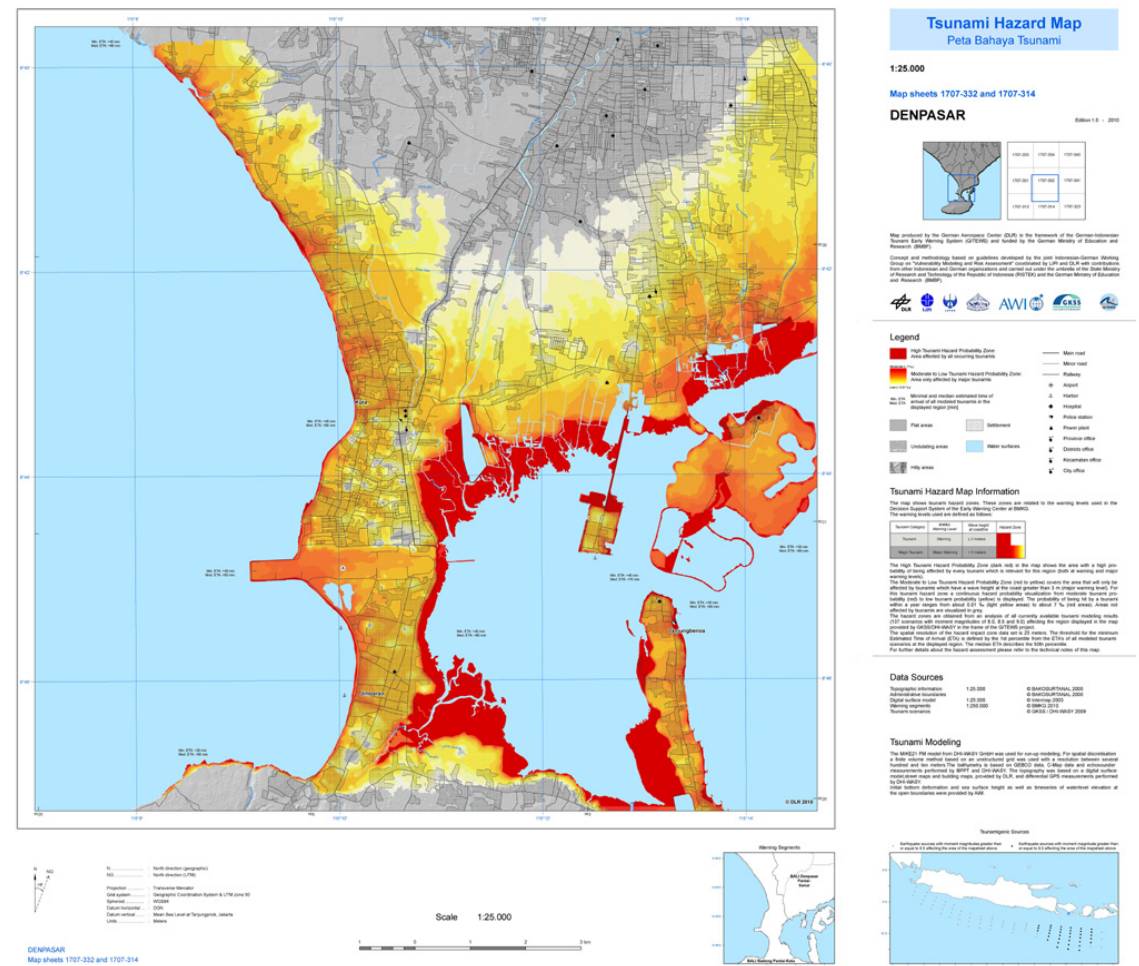
Fig. 2. Tsunami Hazard Map for